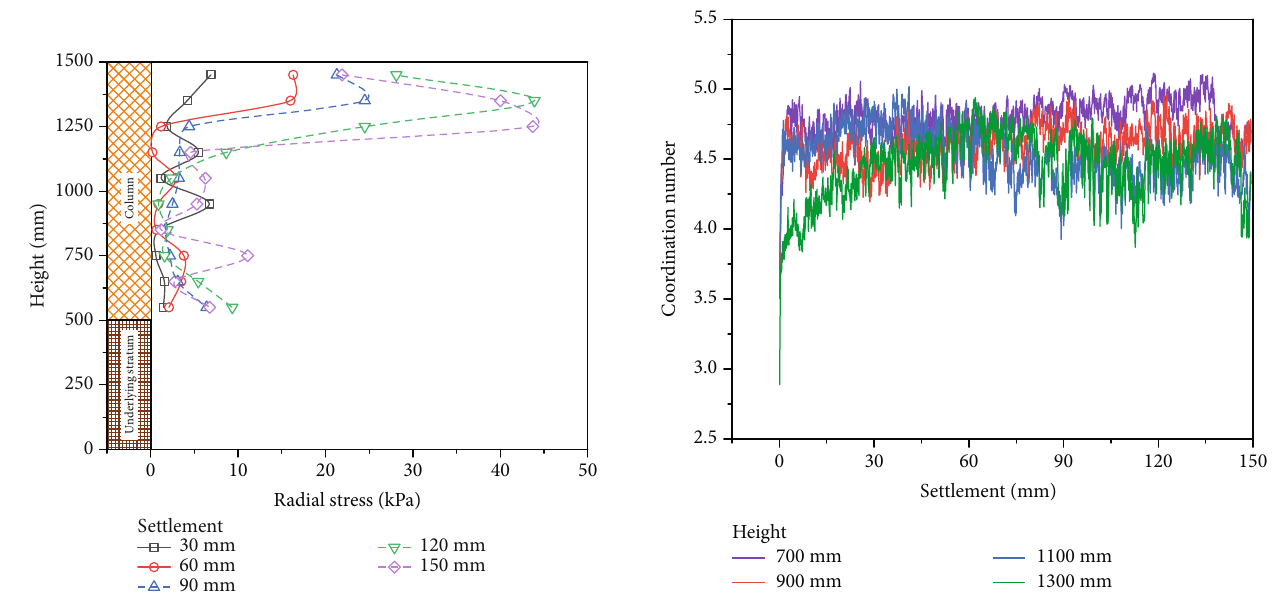
Figure 7: Coordination number in the column during